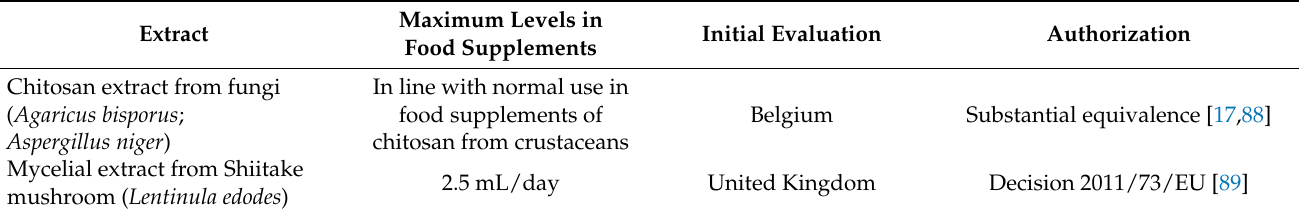
Table 5. Extracts of fungal origin authorized as novel foods for its use in food